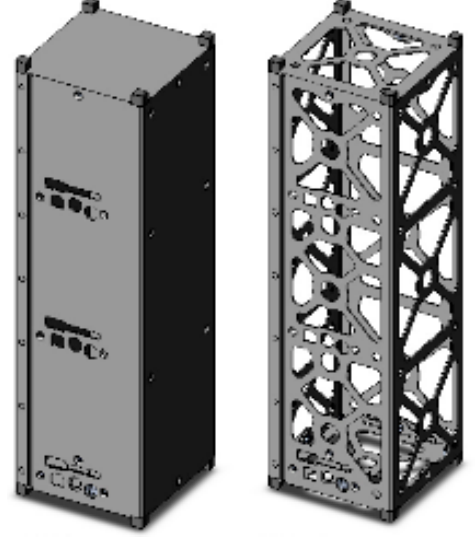
Figure 32. 3U Monocoque Walled Primary Structure (Pumpkin Incorporated, 2015) [48].